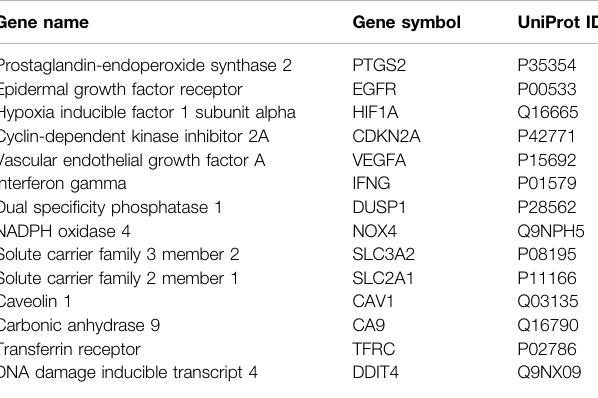
TABLE 1 | Information of GSH anti-oral cancer